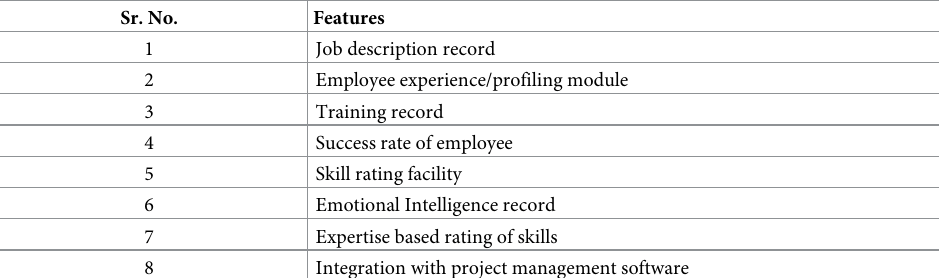
Table 1. Features of framework.